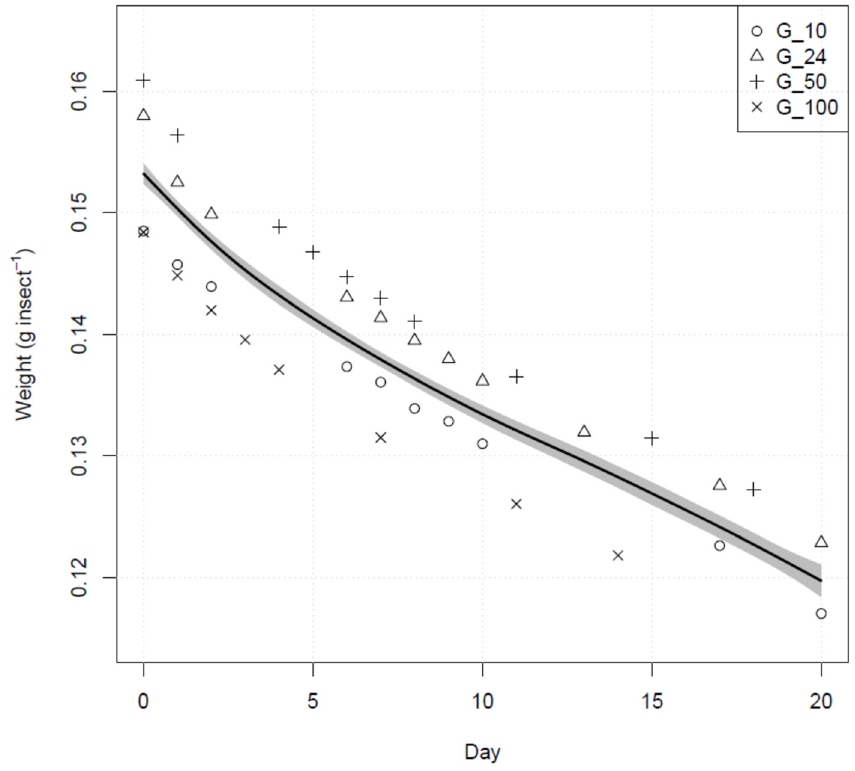
Figure 1. Trend of the mean weight per insect in four groups of H. halys with different sample size recorded during the 20 days following diapause. The solid black line represents a smoothed model of the daily weight as inferred through GAMM. The shade grey area represents 95% confidence intervals.